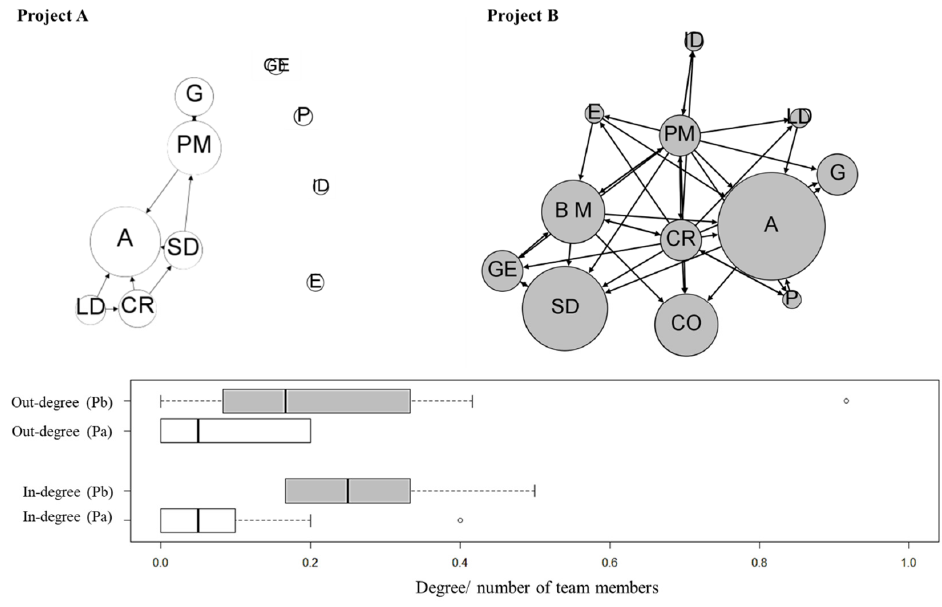
Figure 7. Learning network and degrees: Project A and project B.